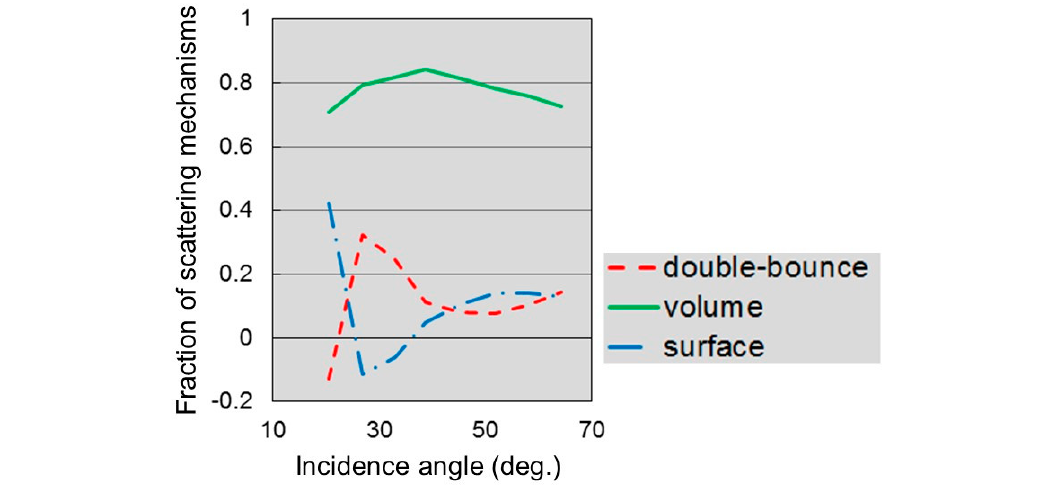
Figure 9. Freeman and Durden’s three-component scattering decomposition result for block D